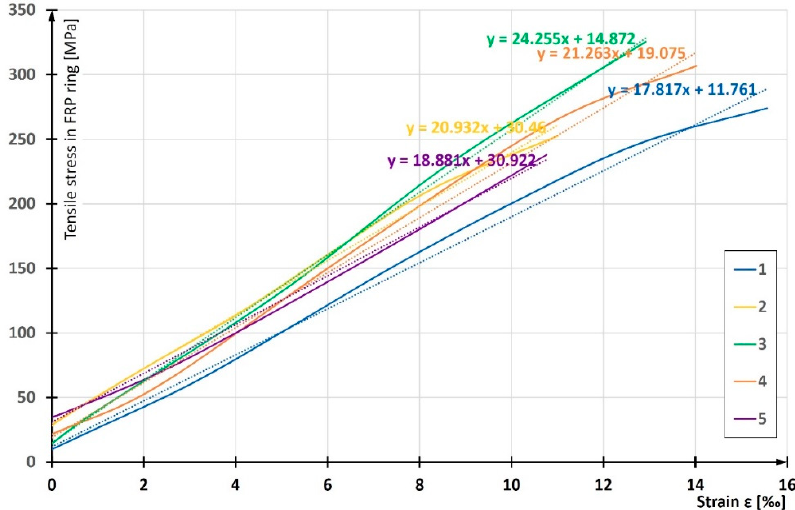
Figure 11. Idea of determining modulus of elasticity at circumferential tension, presented for FRP ring samples of pipe with winding angle θ = 55°.